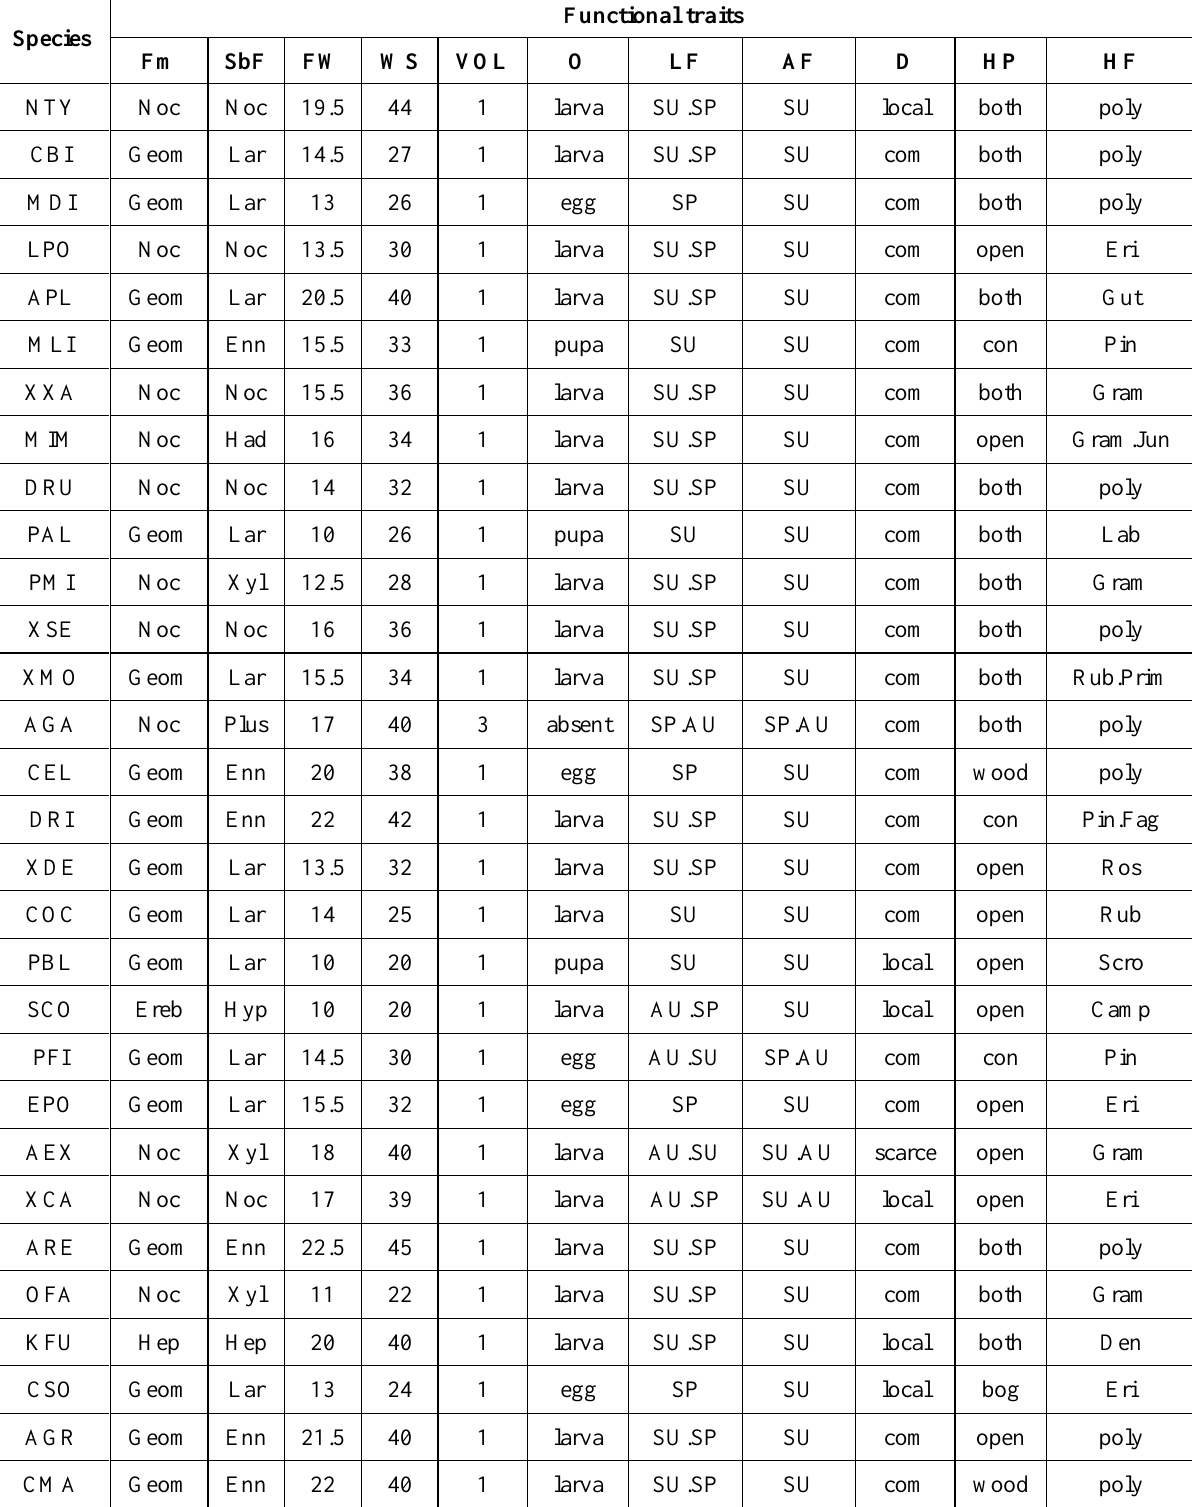
Table A2. Moth species functional traits. Taken from Waring & Townsend (2009), Manley (2015) and Money (2017). Species codes are given in Table A1 and trait codes are defined in Table 2. Fm = family; SbF = subfamily; FW = forewing length; WS = wingspan; VOL = voltinism; O = larval overwintering; LF = larval feeding season; AF = adult flying period; D = distribution; HP = habitat preference; HF = host plant